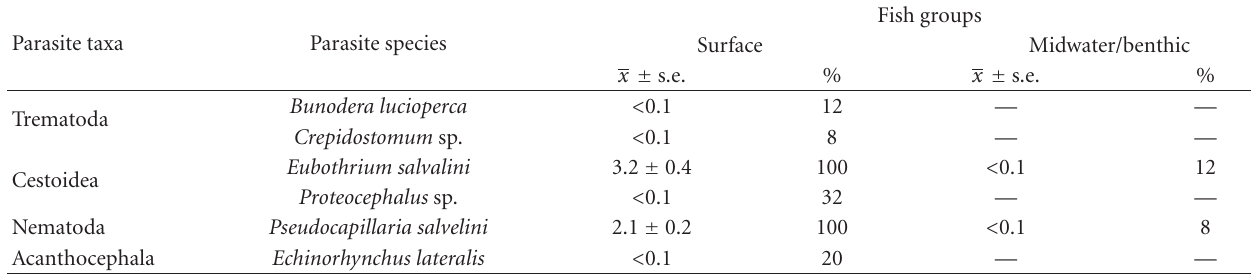
Table 2: Comparison of the abundance ( x ± s.e.) and prevalence (%) of some metazoan parasites found in the digestive tract of two populations of Arctic charr ( n = 25) living near the surface and in the midwater benthic zone of Gander Lake, Newfoundland. Parasite